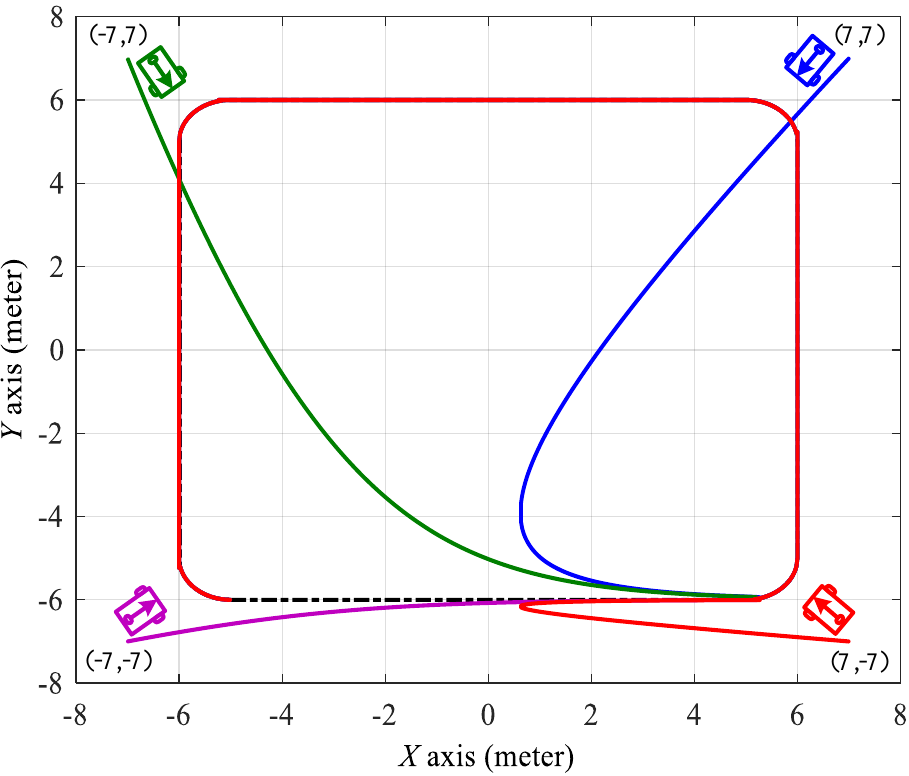
Figure 3. The verification result of the square trajectory by the adaptive H 2 closed-form control approach from x p = 7 m, y p = 7 m (blue line), x p = − 7 m, y p = 7 m (green line), x p = − 7 m, y p = − 7 m (purple line), x p = 7 m, y p = − 7 m (red line).